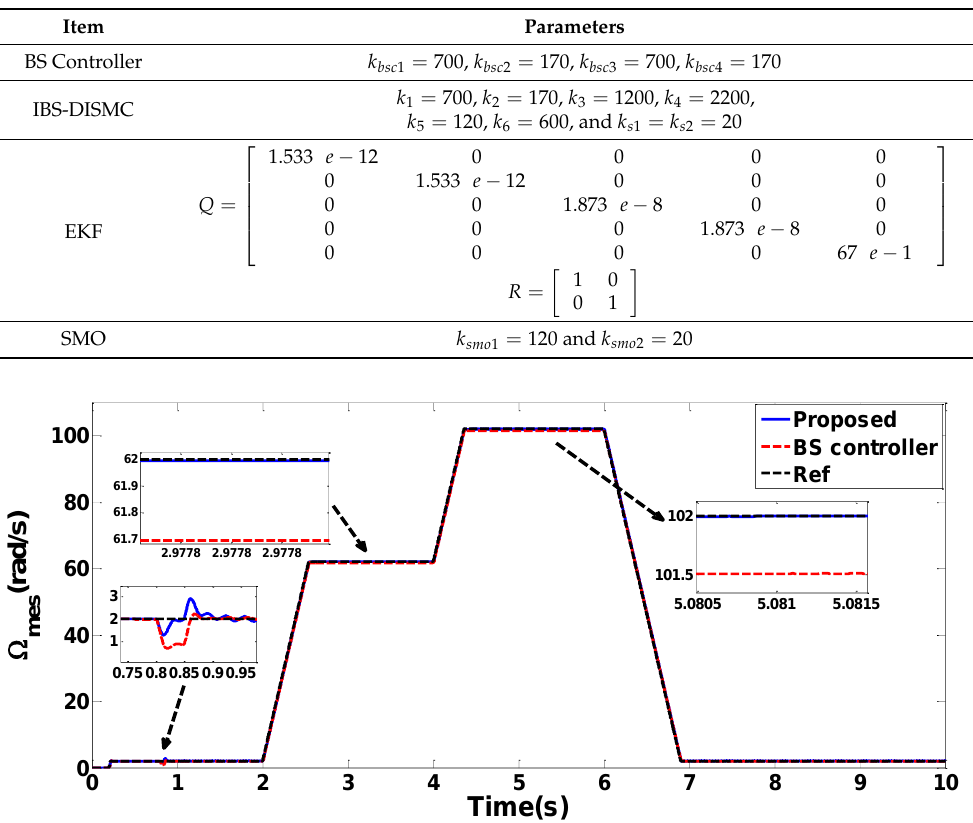
Figure 3. Velocity responses of the induction machine using BSC and IBS-DISMC for a stator winding resistance change of +25%. Table 1. The parameters of the IM machine. Parameters